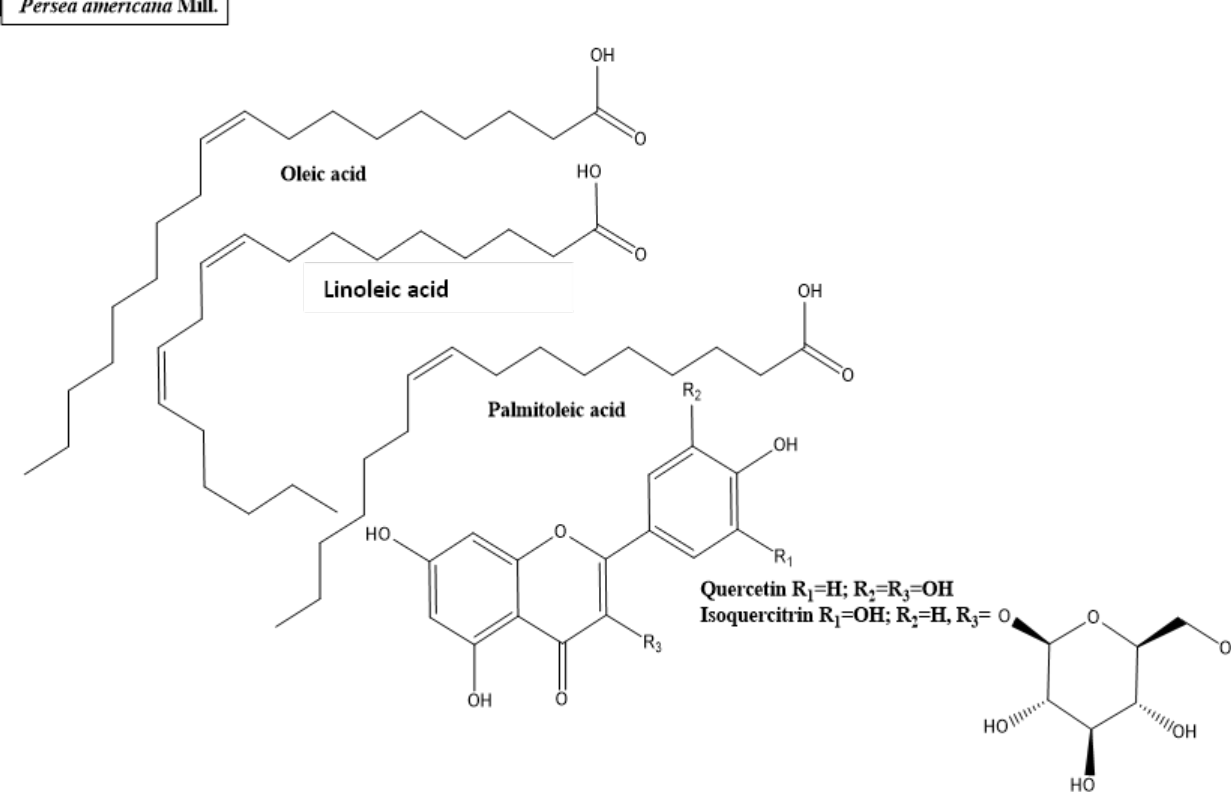
Figure 5. Chemical structures of bioactive phytocompounds with reported antidiabetic properties identified in Persea americana